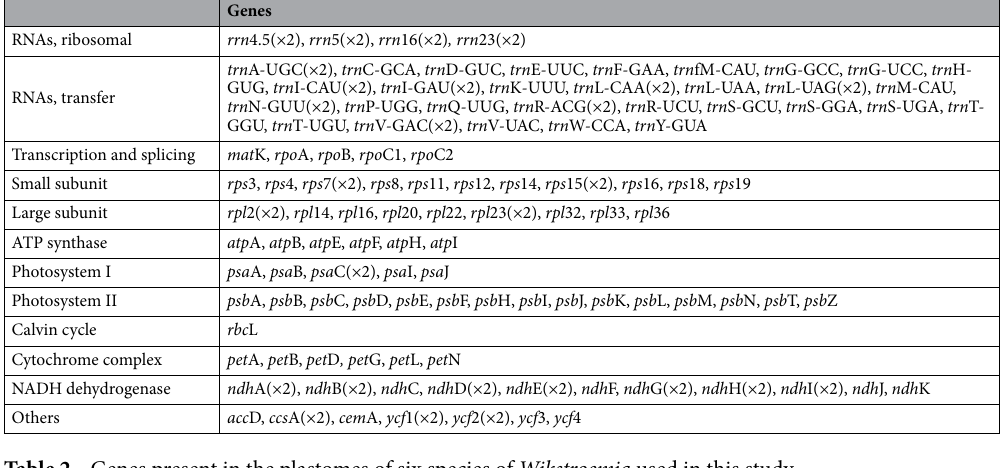
Table 2. Genes present in the plastomes of six species of Wikstroemia used in this study.